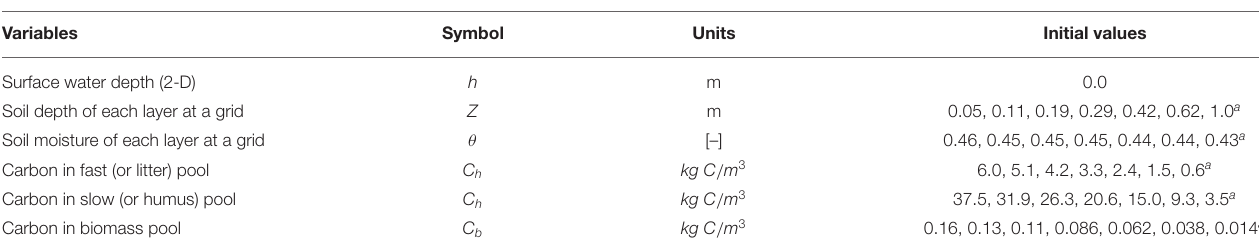
TABLE 1 | Variables and initial